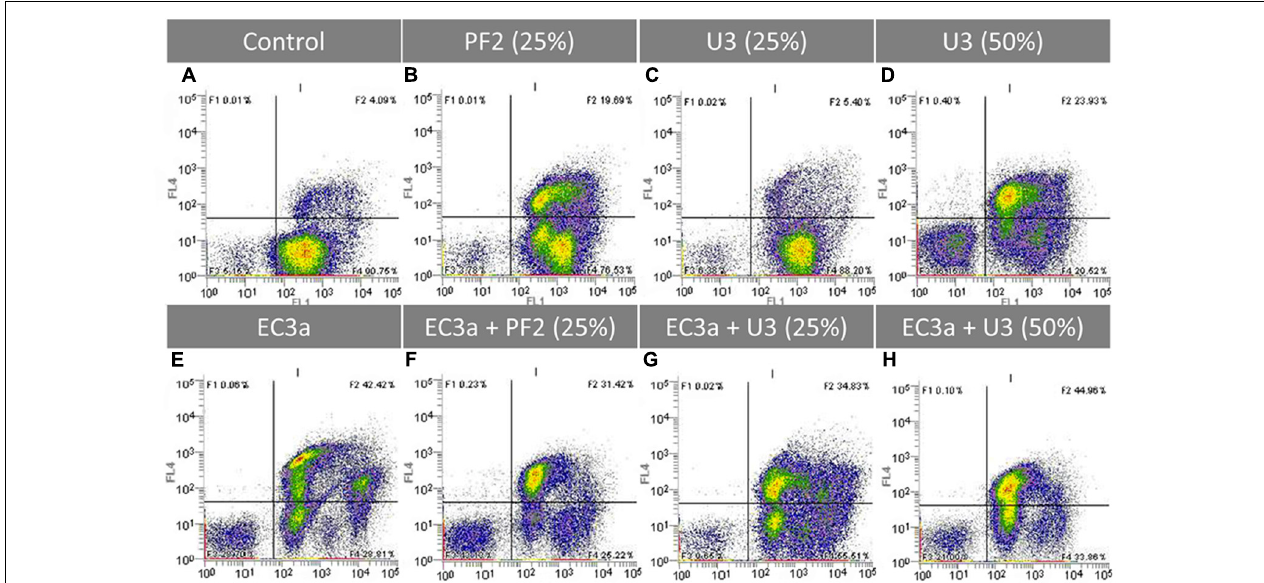
FIGURE 7 | Flow cytometric analysis after 12 h application of single and combined treatments to 24-h-old E. coli biofilms. Representative dot plot FL1 ( x -axis) vs FL4 channel ( y -axis) showing E. coli cells stained with SYTO BC (250 nM) and PI (20 µ g . mL − 1 ). (A) E. coli control, (B) PF2 25% , (C) U3 25% , (D) U3 50% , (E) EC3a phage at a MOI 10, (F) phage–PF2 25% at a MOI 10, (G) phage–U3 25% at a MOI 10, (H) phage–U3 50% at a MOI 10. Results are a representative example of two independent